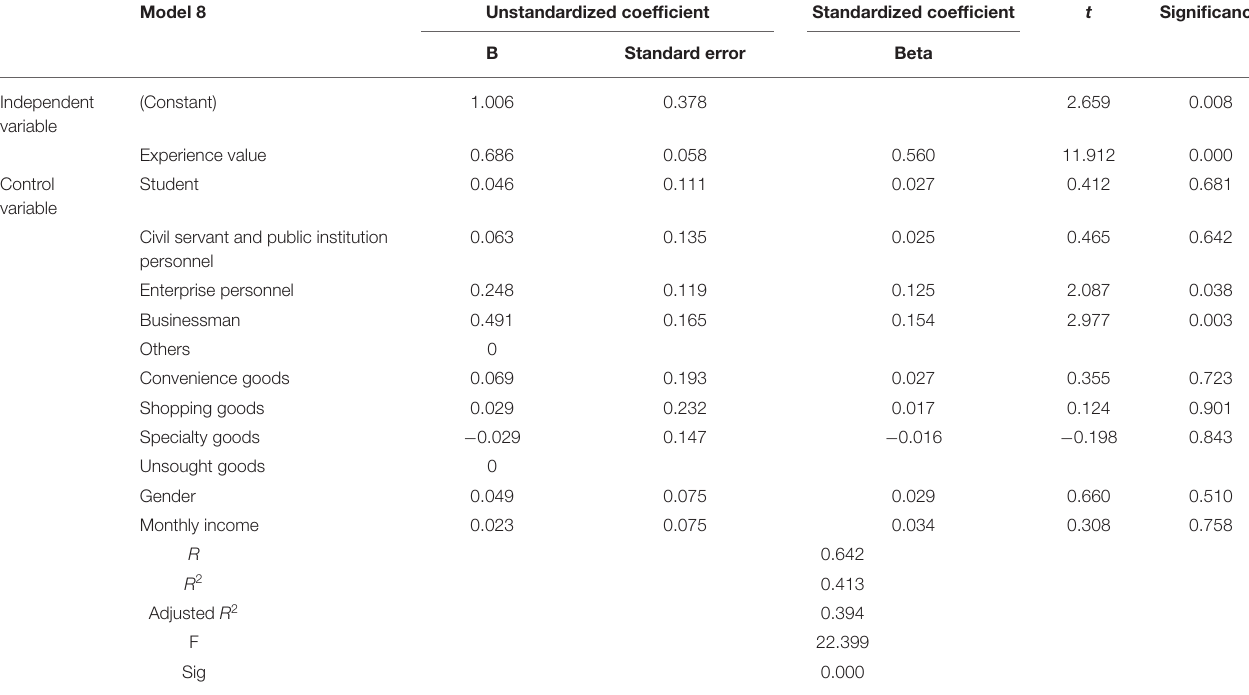
TABLE 9 | Regression analysis of experience value to consumers’ purchase